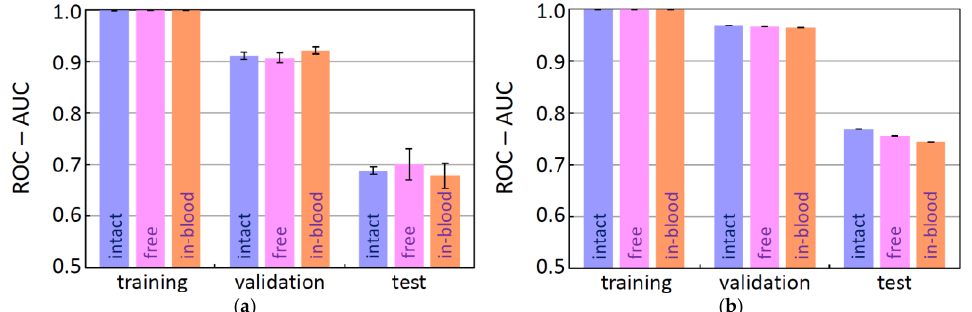
Figure 2. The ROC-AUC scores in comparison of the three datasets: intact, free-form, and in-blood- form datasets, using a DNN model ( a ) and a RF model ( b ) with 200 molecular descriptors.